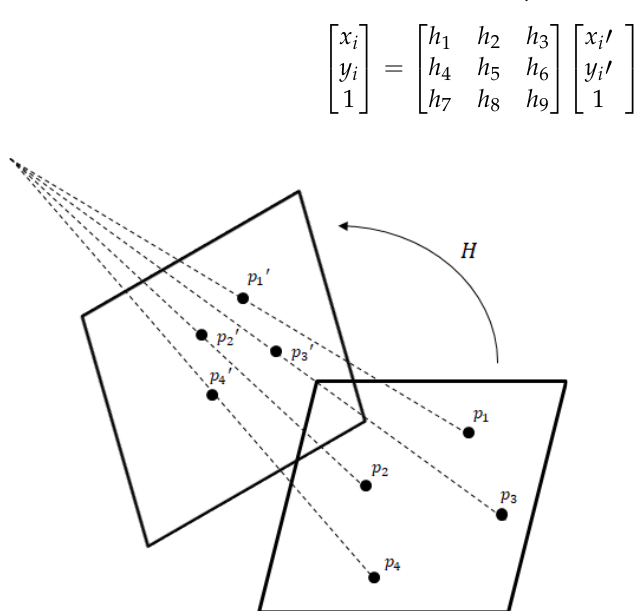
Figure 7. Homography. Figure 7.